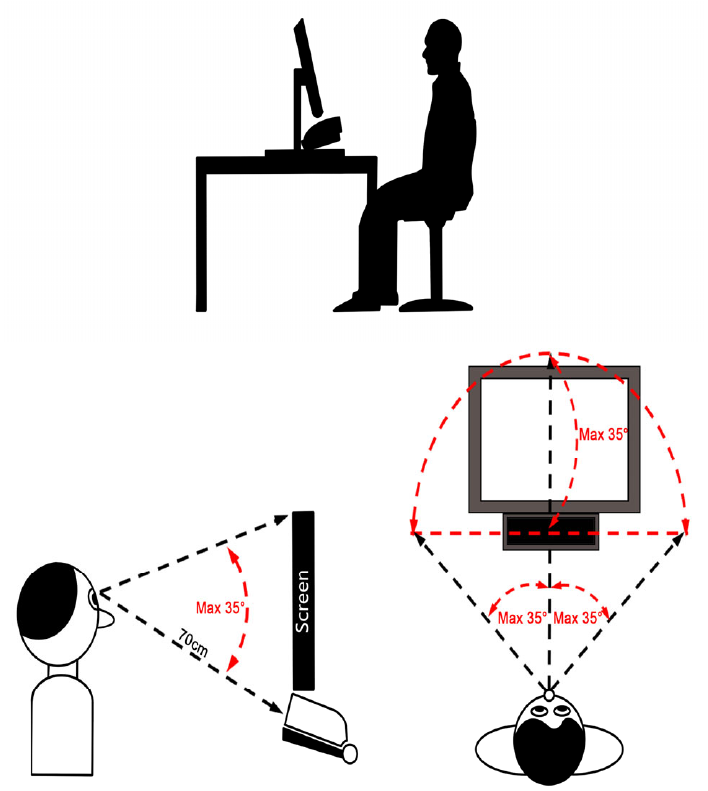
Figure 3. The operation specification of the Tobii X120 Eye Tracker experiment.